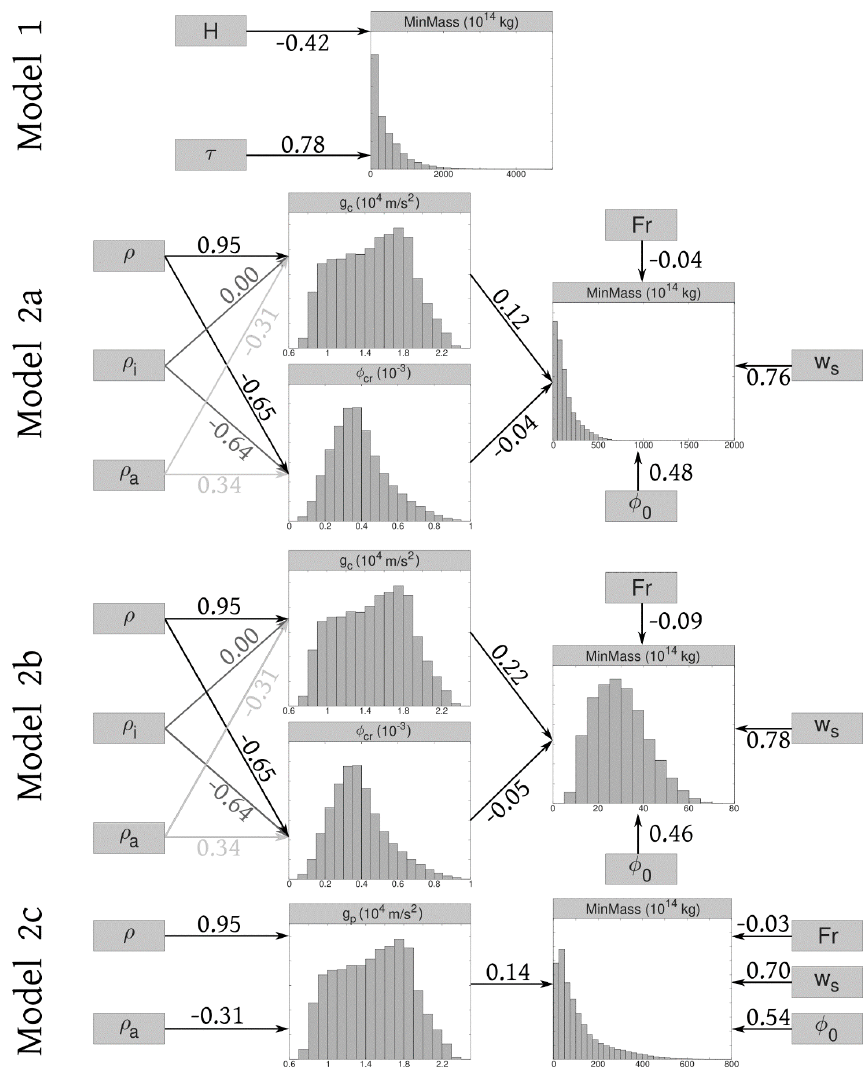
Figure 6. Sensitivity analysis of the evaluation of functional variable MinMass in the different models used in this work. Gray boxes indicate the input parameters, and arrow labels indicate correlation coefficients in relation to model inputs and functional variables. BBN based on 100000 statistical